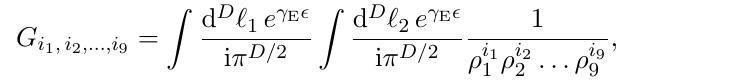
q topologies relevant for the double-box master j j